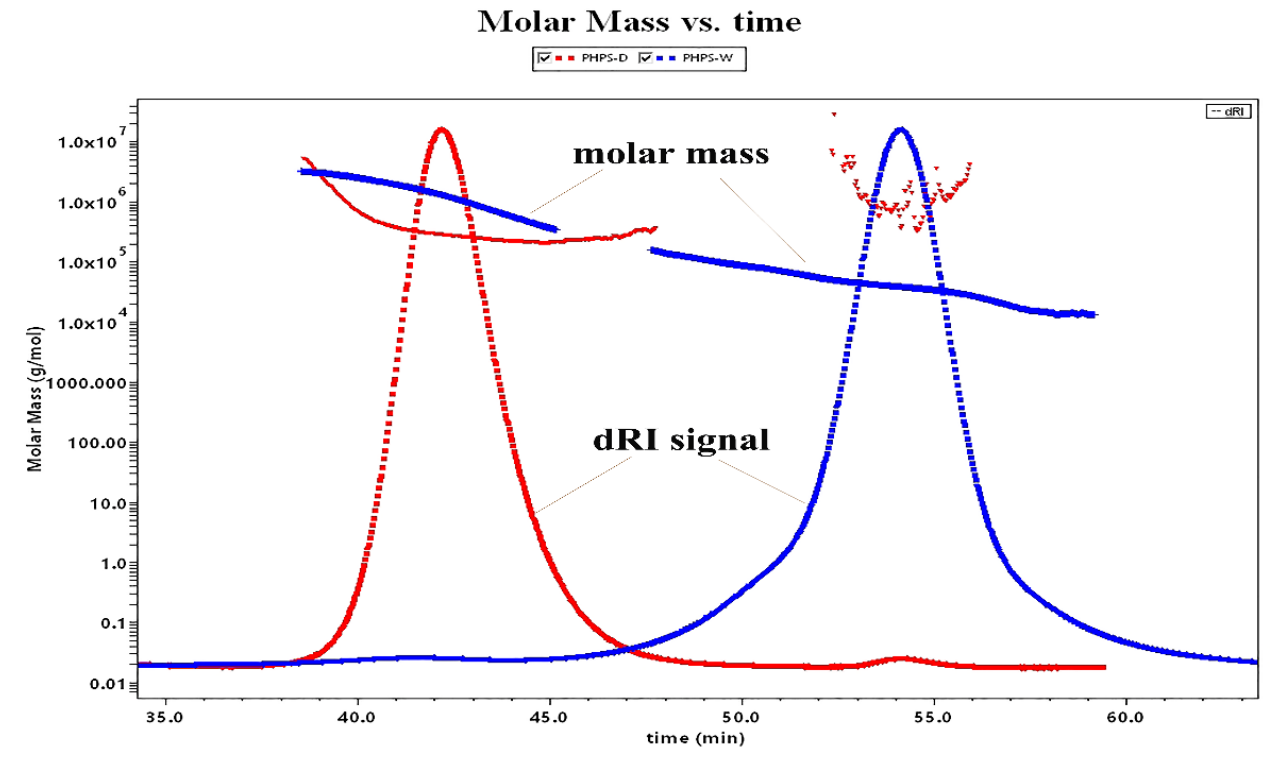
Figure 4. Molar mass profiles of the SEC-MALLS chromatogram for PHPS-D and PHPS-W in 0.15 mol/L NaNO 3 at 25 °C.